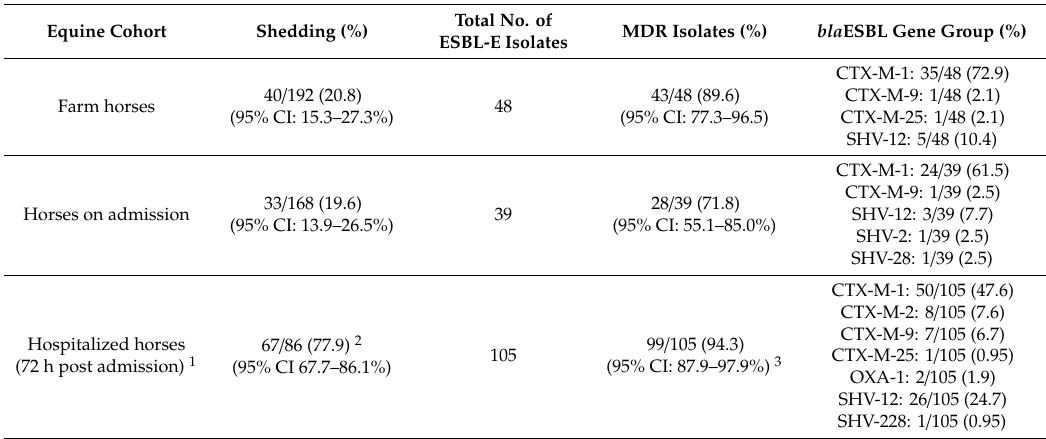
Table 2. Shedding rates of extended-spectrum beta-lactamase-producing Enterobacteriaceae ( ESBL-E) in farm horses, on admission, and during hospitalization.